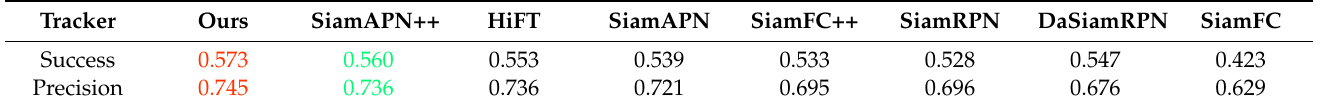
Table 2. UAV20L benchmark comparison table, the table shows the success rate and precision results of 8 trackers including ours. The proposed SiamHAS performs favorably against state-of-the-art trackers. The best method is shown in red, and the second is shown in green.